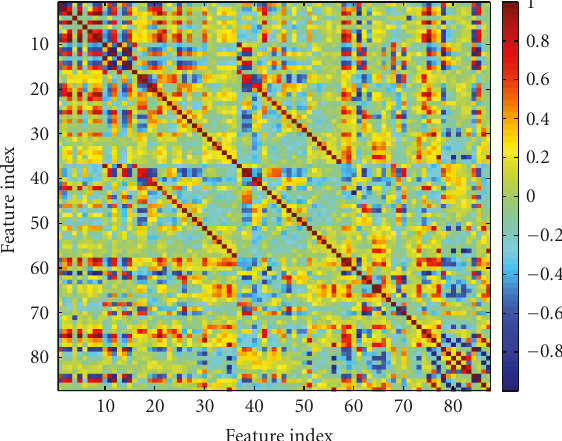
a classification system. In order to eliminate the redundant information in the features, the correlation between features is first computed. This operation is included in the second part of the analysis system (see Figure 4).